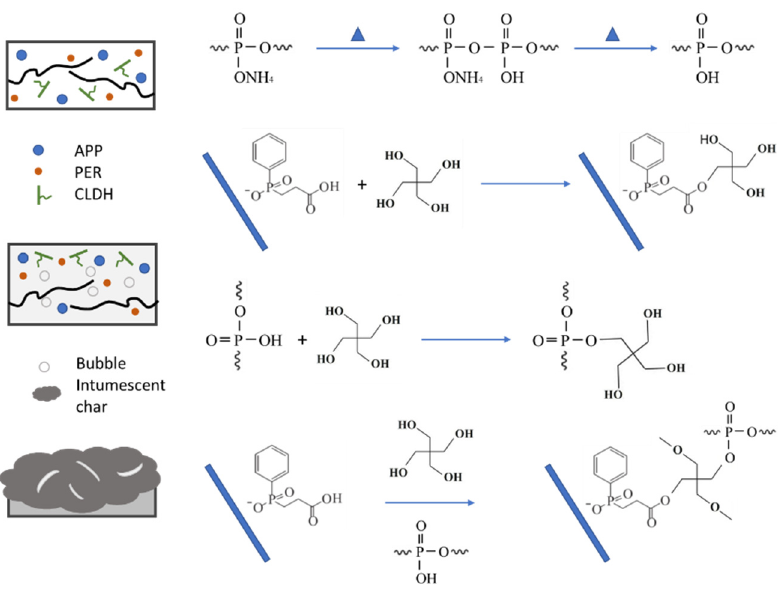
Figure 8. Schematic diagram of the flame retardant mechanism of